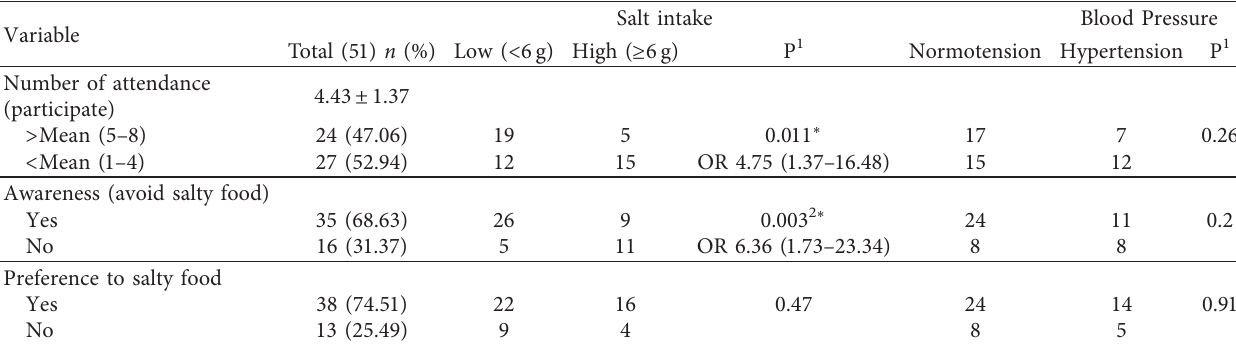
Table 4: Bivariate analysis for factors associated with salt intake and hypertension